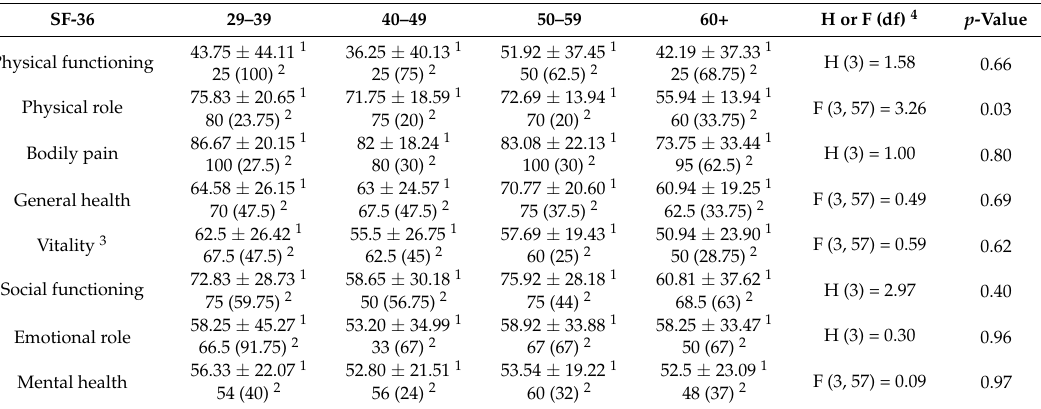
Table 4. Significant effects of age on SF-36